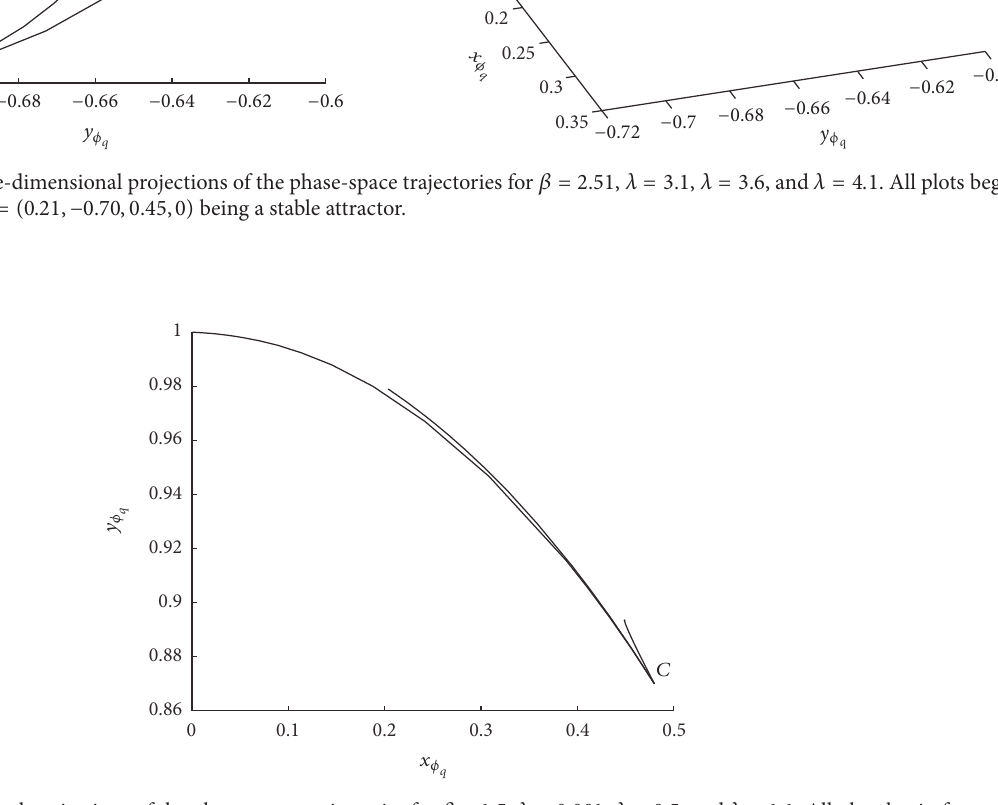
Figure 3: Two-dimensional projections of the phase-space trajectories for 𝛽 = 1.5 , 𝜆 = 0.001 , 𝜆 = 0.5 , and 𝜆 = 1.1 . All plots begin from the critical point 𝐶 = (0.48, 0.87,0, 0) being a stable